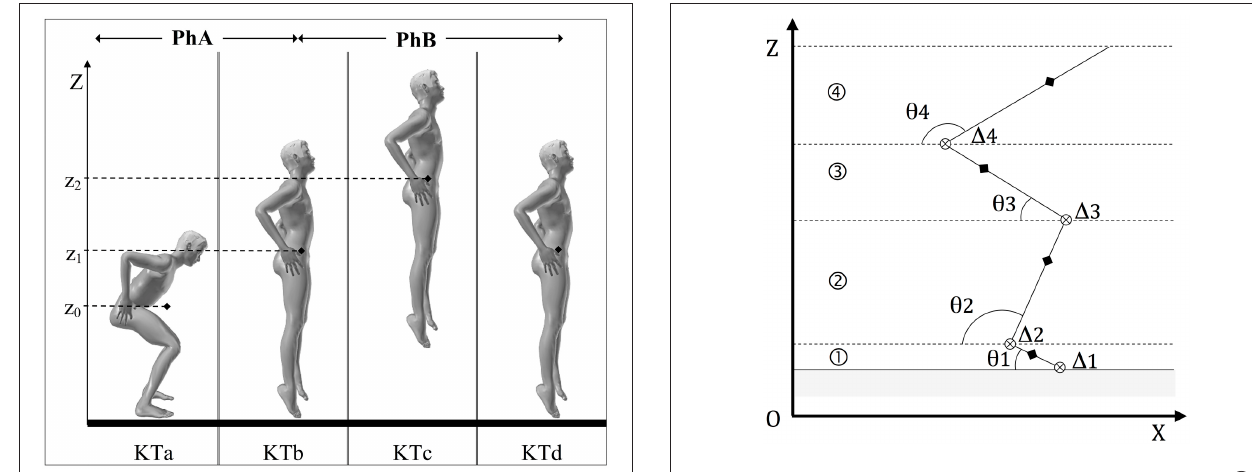
FIGURE 1 | Key times (KTa-d), phases (PhA-B), and performance (h) of a VSJ. KTa: initial position (the jumper stands still, heels on the ground, knee joint angle of ∼ 90 ◦ , hands on hips); KTb: take-off (end of contact between the support and the jumper); KTc: peak of the flight phase (the mass center of the jumper, MC, reaches its maximal height of flight); KTd: landing (moment at which the feet touch again the ground); PhA: push-off phase (realized without initial countermovement, it starts at t0 when the segments of the jumper begin to rotate and ends at take-off); PhB: flight phase (it starts at take-off and ends at the instant of landing). The height of the jump (h) is given by the difference between the vertical coordinate of MC ( (cid:7) ) at take-off (z1) and at the peak of the flight phase (z2): h = z2 − z1. During the push-off the coordinate of MC evolve from z0 (initial position) to z1 (instant of take-off) and then to z2 (apex of the jump).